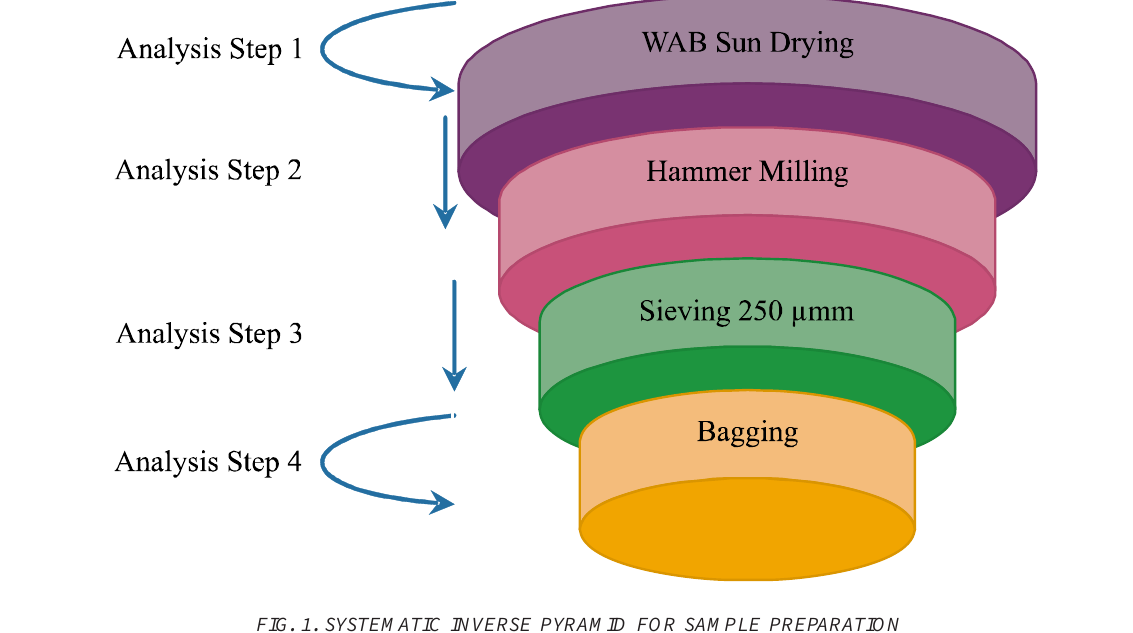
FIG. 1. SYSTEMATIC INVERSE PYRAMID FOR SAMPLE